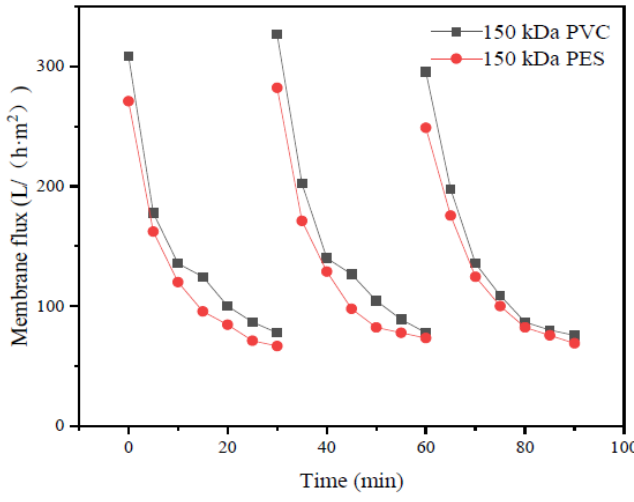
Figure 5. Variations in membrane flux with time for the different MWCO UF membranes.